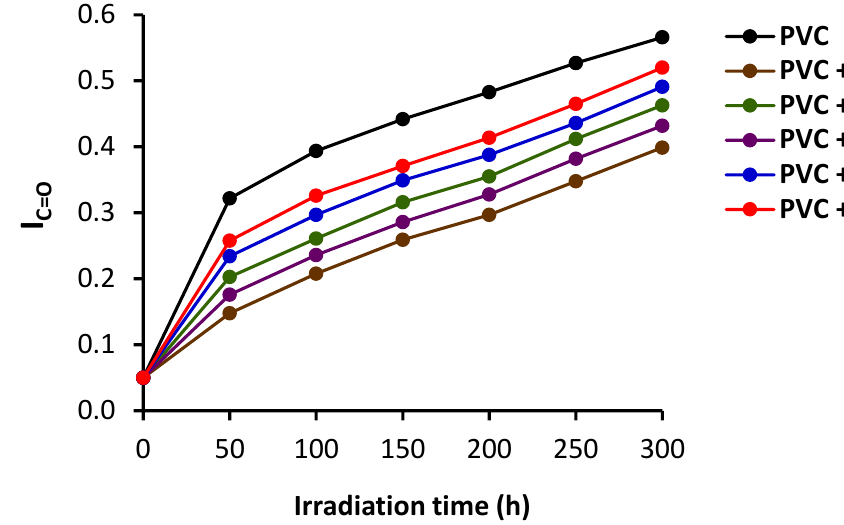
Figure 5. The I C=O of the irradiated PVC films.